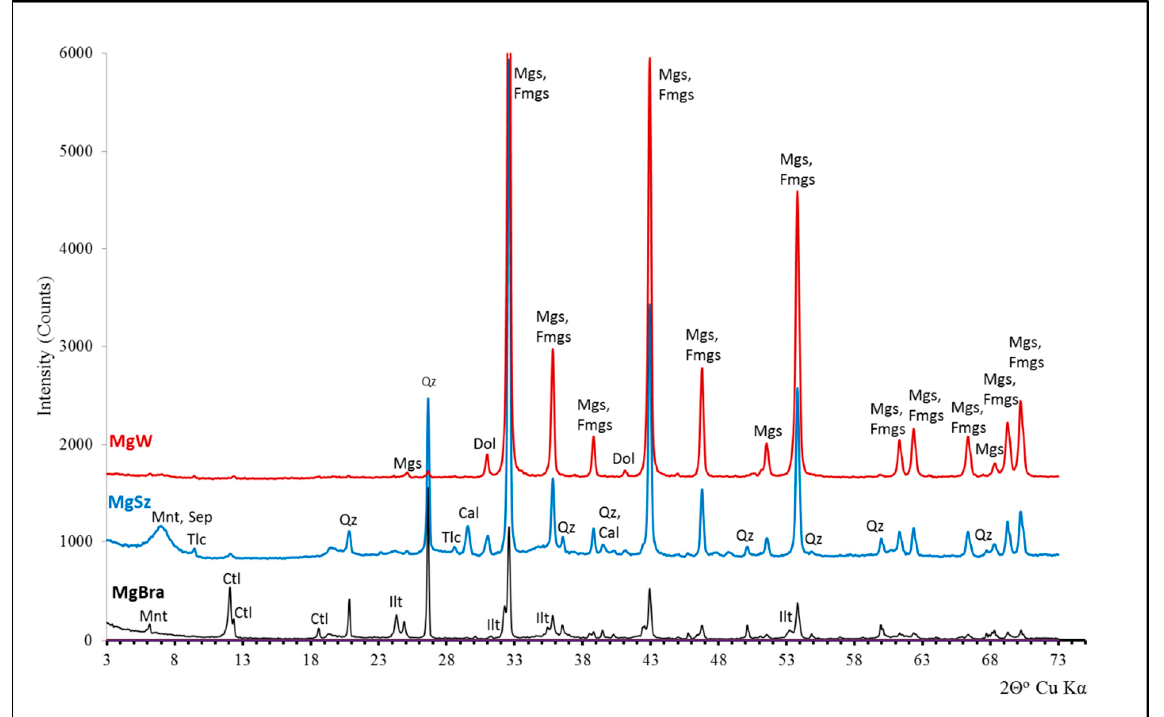
Figure 5. Phase compositions of magnesite from the Braszowice deposit (MgBra), Szklary deposit (MgSz) and Wiry deposit (MgW) are shown in the diffraction patterns. Explanations: Mnt—mont- morillonite (Na,Ca) 0,3 (Al,Mg) 2 Si 4 O 10 (OH) 2 · nH 2 O); Sep—sepiolite (Mg 4 (Si 6 O 15 )(OH) 2 · 6H 2 O); Tlc— talc (Mg 3 Si 4 O 10 (OH) 2 ); Ctl—clinochrysotile (Mg 3 (Si 2 O 5 )(OH) 4 );